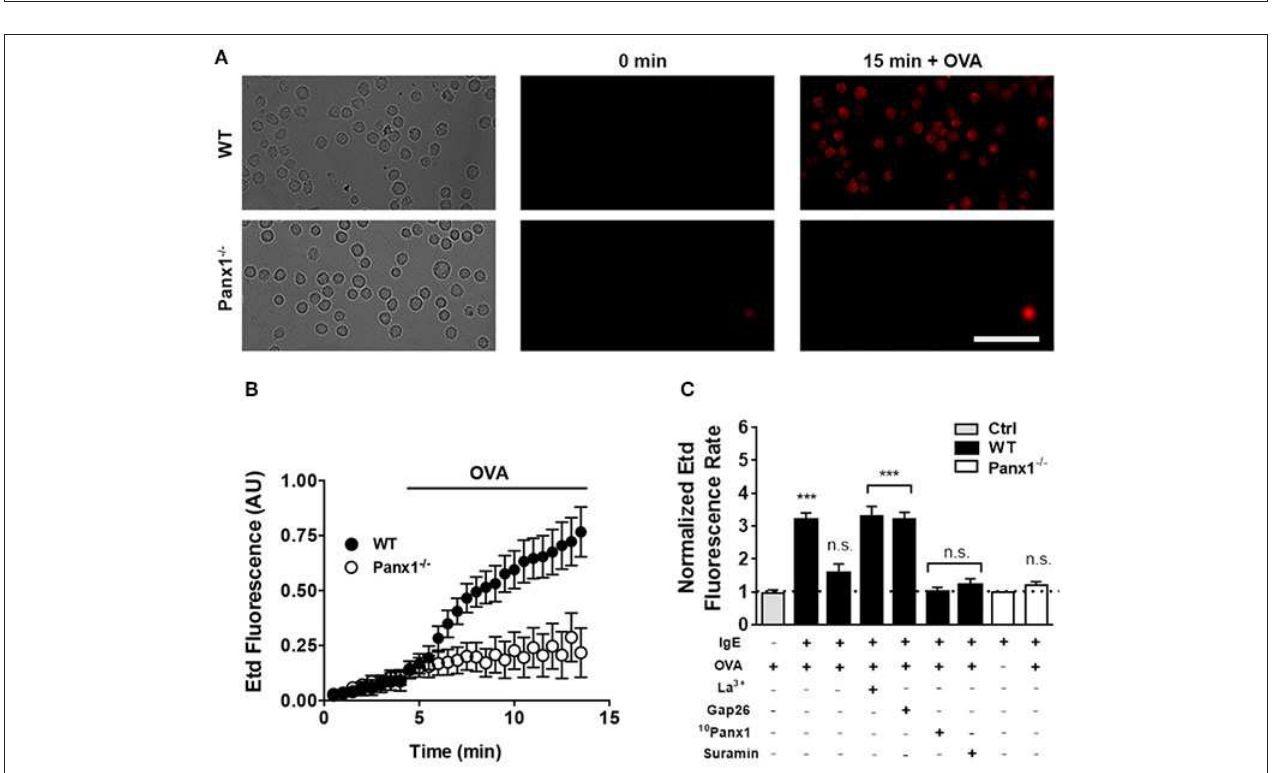
FIGURE 3 | OVA recognition promotes Panx1-dependent membrane permeability changes in sensitized mast cells. The membrane permeability of mast cells (MCs) was evaluated with the ethidium (Etd) uptake technique. (A) Time-lapse of Etd uptake during 5min under basal conditions followed by 10 µ M OVA stimulation in sensitized WT (black) and Panx1 − / − MCs (white). (B) Time-lapse measurement of fluorescence intensity of MCs as described in (A) . (C) Normalized Etd uptake rate values were calculated by determining the fluorescence intensity slope and normalized to the basal conditions. The gray bar represents the Etd uptake rate of non-sensitized control MCs (Ctrl). The first black bar corresponds to the normalized Etd uptake rate during the first 2.5min of OVA stimulation and the second black bar corresponds to the normalized Etd uptake rate after the first 2.5min of recording in sensitized WT MCs treated with OVA. All other conditions correspond to sensitized WT and Panx1 − / − MCs pretreated during 20min with a Cx HC blocker [200 µ M lanthanum ion (La 3 + ) or 200 µ M Gap26 to block Cx43 HCs or 200 µ M 10 Panx1 to block Panx1 Chs] followed by OVA stimulation for additional 10min. In cells treated with La 3 + or Gap26, the Etd uptake rate was evaluated during the first 2.5min of stimulation with OVA. Under all other conditions, the dye uptake curve was linear. Each point corresponds to the mean ± SEM, n = 3, between 30 and 50 cells were recorded in each experiment, *** p < 0.0005; no significance (n.s.) p > 0.05.